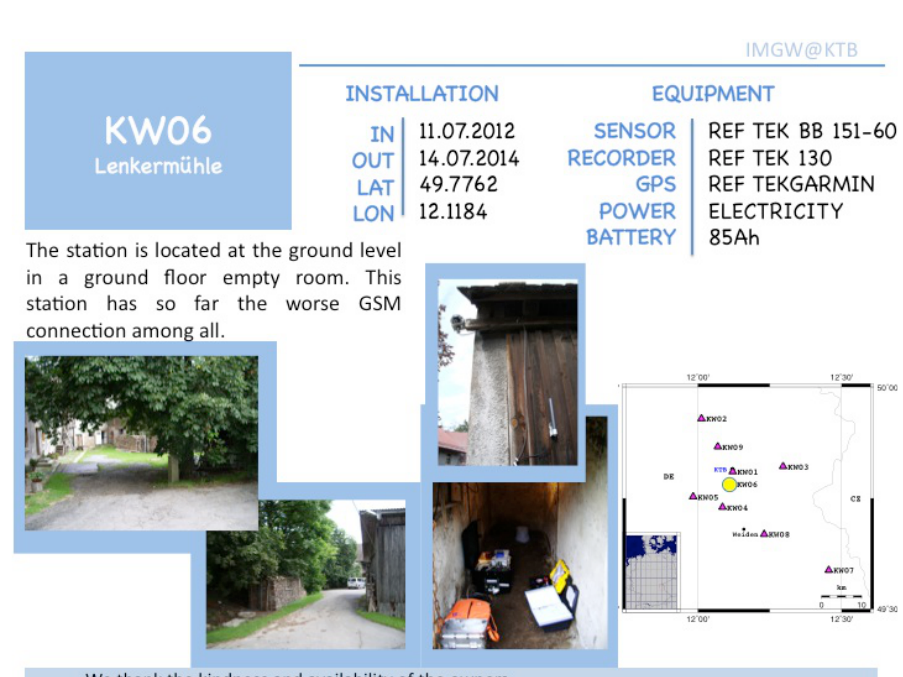
Figure A6. Station KW06 technical